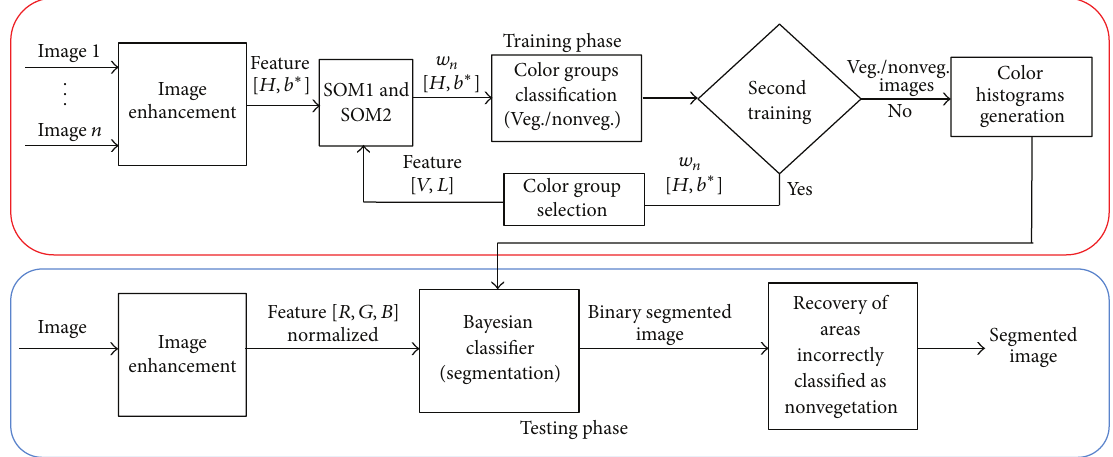
Figure 1: Blocks diagram of the SEVUE methodology. Two phases are performed: training and testing phases. The main processes of SEVUE are the following: an image enhancement to adjust the color and brightness levels of the input images; a color clustering process using SOM1 and SOM2 (SOM2 refines the results of SOM1); a classification process by a Bayesian classifier which segments vegetation from input images; and finally a process for recovering areas incorrectly classified as nonvegetation, which at the output will yield the segmented image.